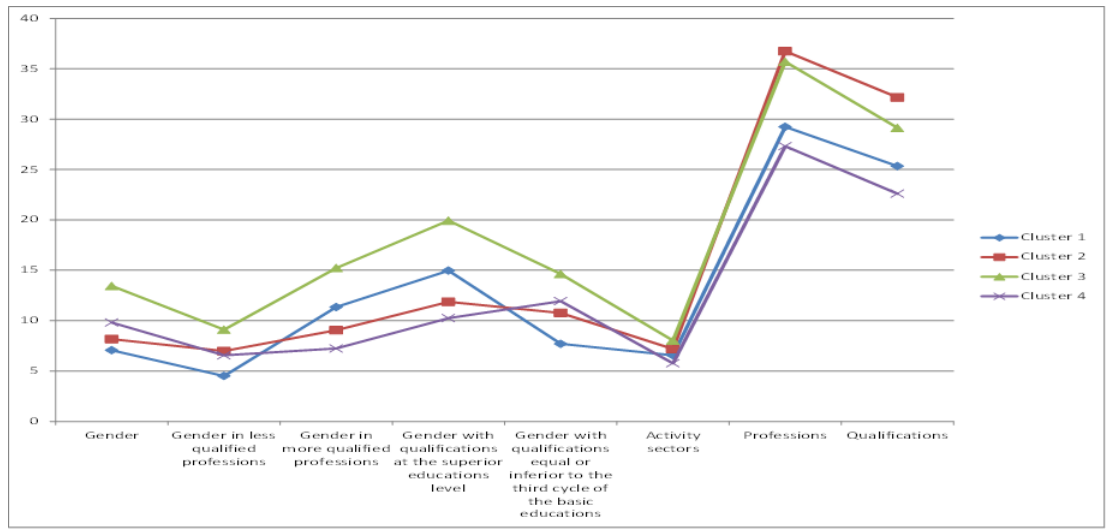
Figure 4. Disparities (average %) in the monthly average earnings by employees and for all clusters.